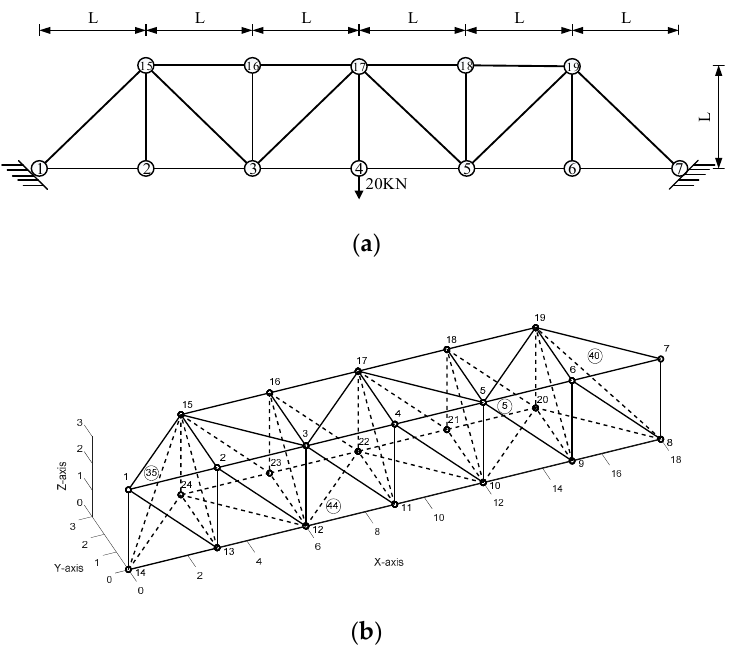
Figure 3. ( a ). X-Y axis elevation structure and force; ( b ). Standard view of the space grid structure of element.